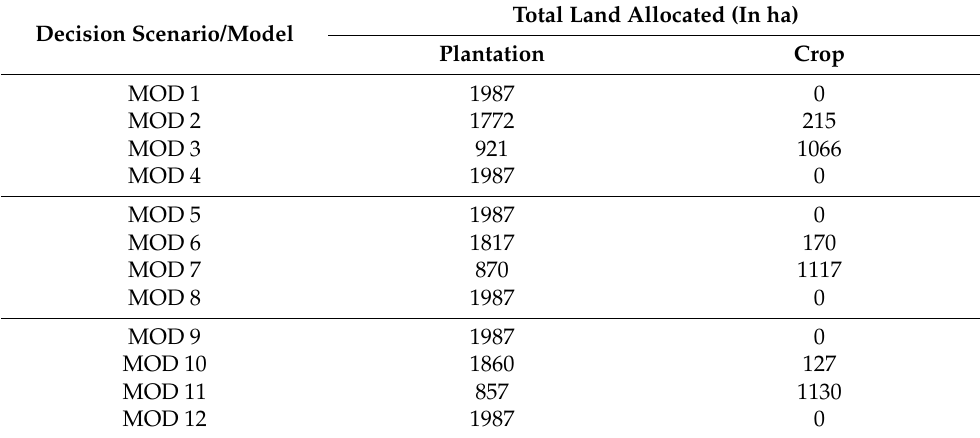
Table 3. Optimal land allocation in each